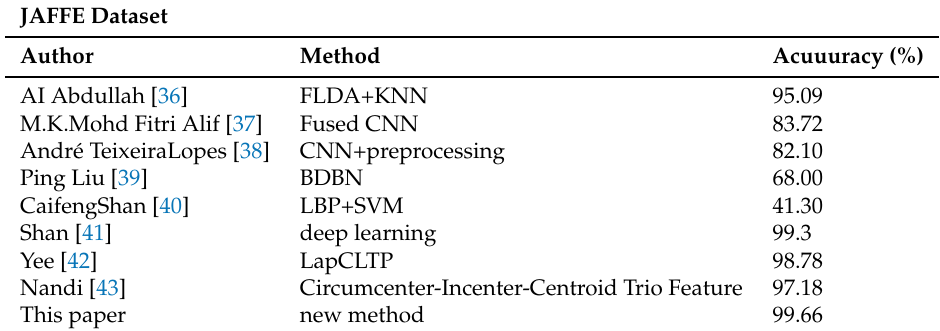
Table 4. This table summarises the current state of the art in facial expression recognition on JAFFE database.